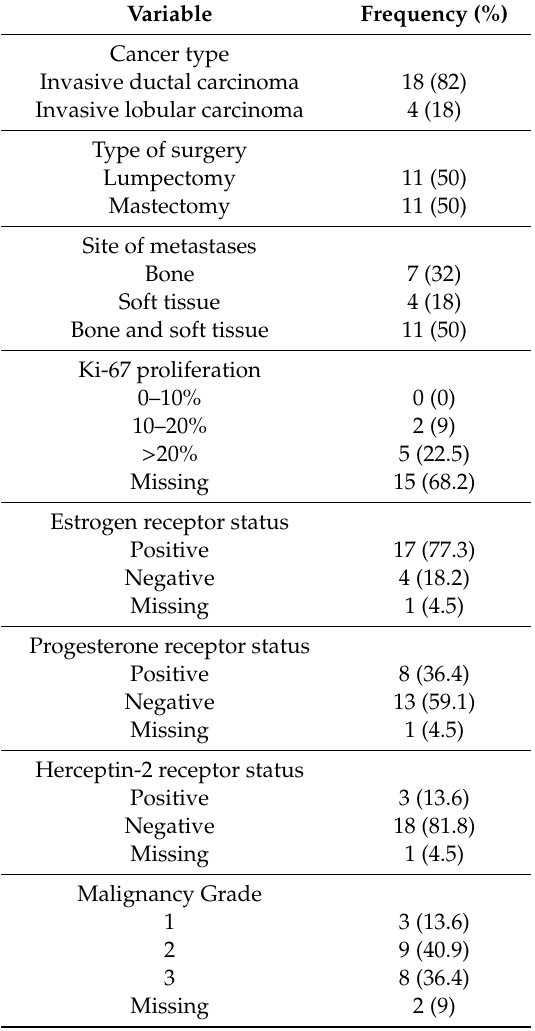
Table 1. Baseline characteristics of included patients with recurrent breast